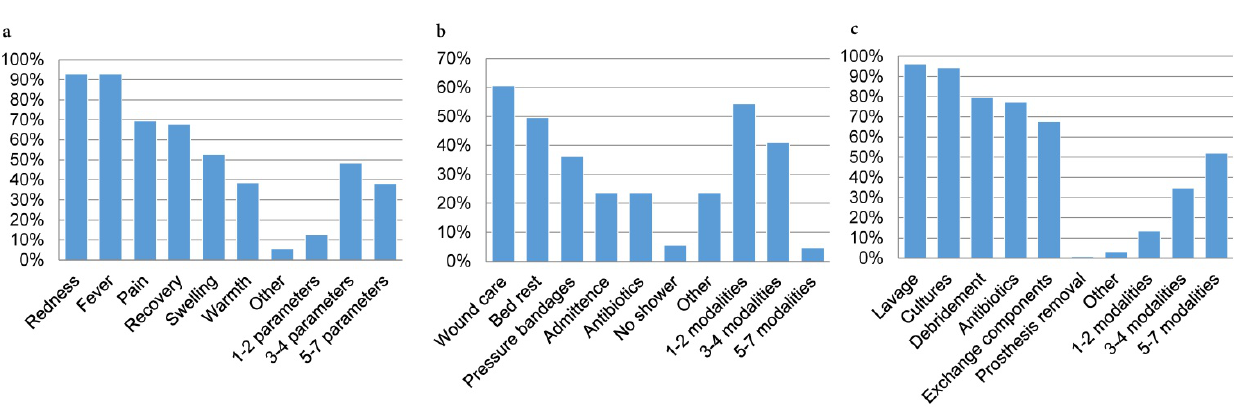
Figure 2. Clinical parameters, non-surgical treatment modalities and surgical treatment (n=127) 2a. Clinical parameters 2b. Non-surgicaltreatment modalities 2c. Surgical treatment